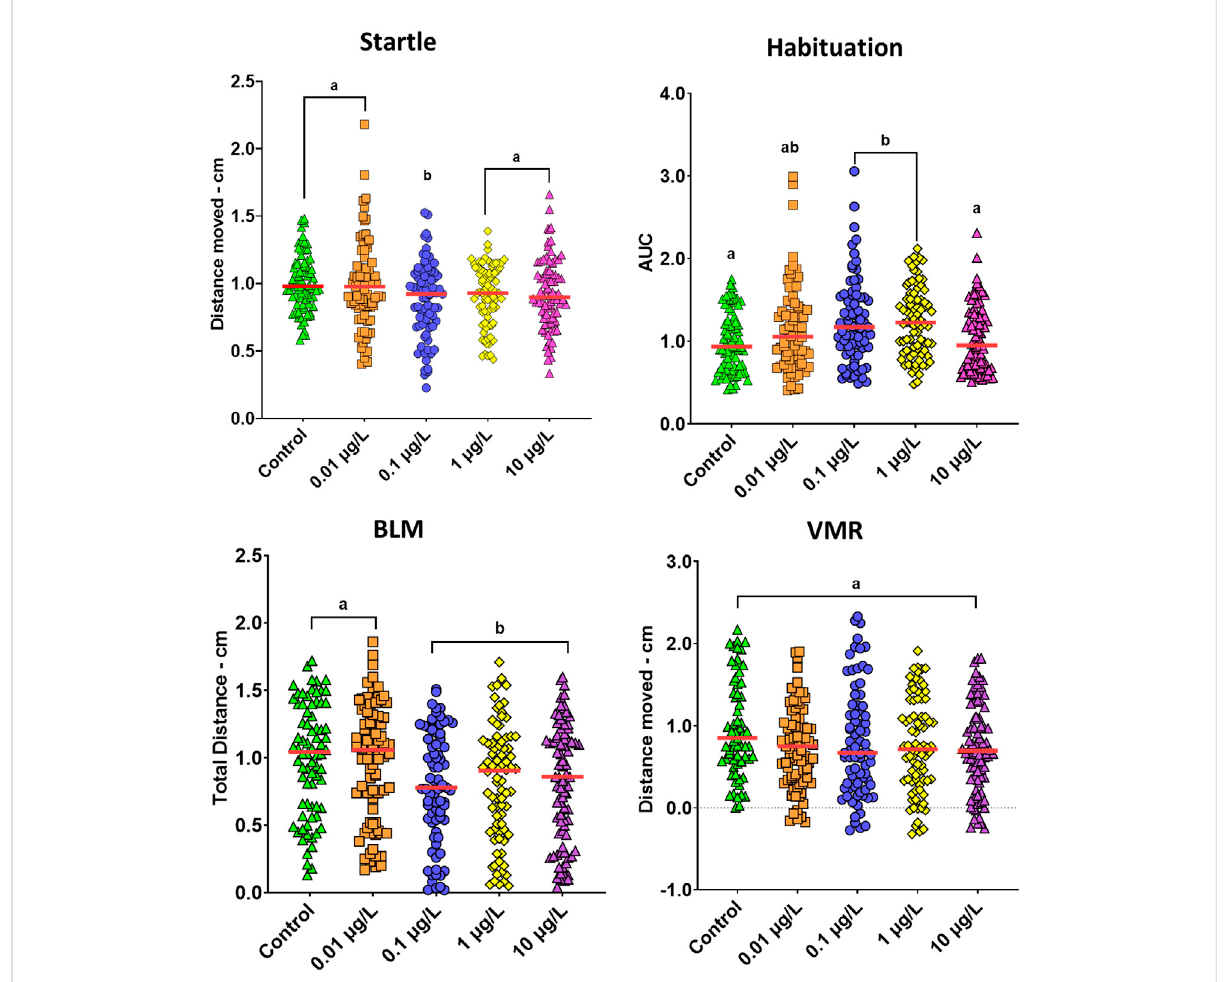
FIGURE 3 Behavioral changes on zebra fi sh eight dpf larvae, following developmental exposure (188 h) to different concentrations of SER. Startle - acoustic/vibrational escape response, represented as the total distance (cm) traveled following the delivery of a tapping stimulus ( n = 79 – 82); Habituation of the acoustic/vibrational escape response evoked by a series of 50 tapping stimuli delivered every second represented as the area under the curve (AUC) of larvae responses (n = 76 – 82). Basal Locomotor (BLM) activity, represented as the total distance (cm) traveled during 10min (n = 76 – 83); Visual-motor response (VMR), reporting the response of larvae due to transition of light to dark, represented as the difference of the total distance (cm) traveled by larvae during 2 minutes after and before the transition of light to dark ( n = 68 – 84); Data are from two to three independent experiments and are reported as scatter plots with the median (red line). Different letters indicate statistical subset groups following either Tukey post hoc (Startle and VMR) or Kruskal Wallis test (Habituation and